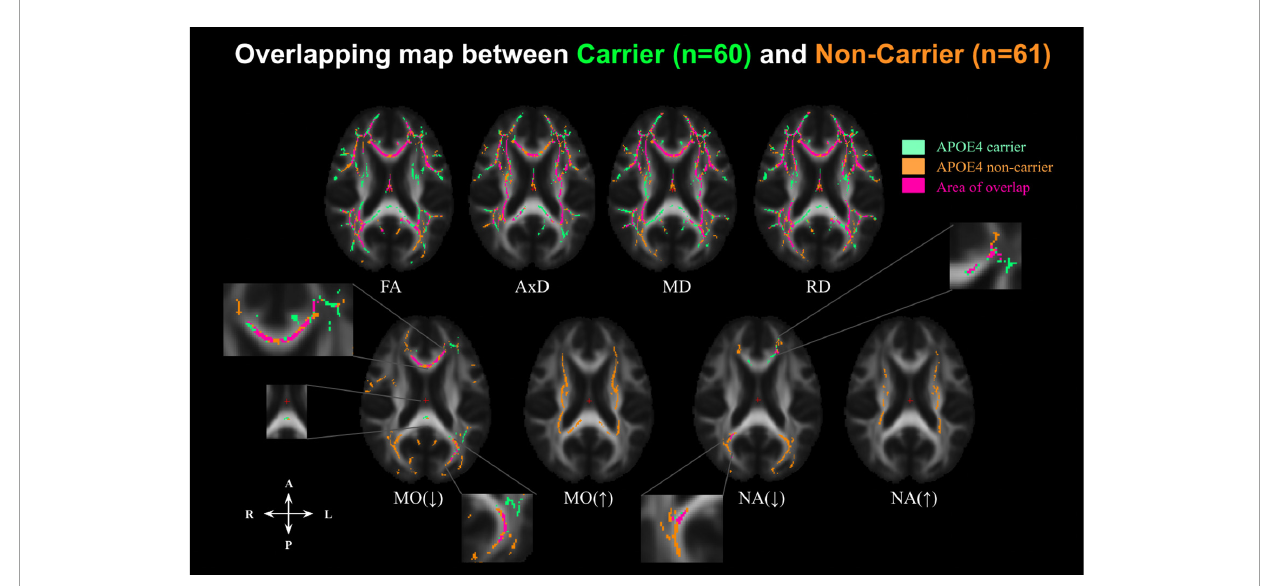
FIGURE3 Significant associations between DTI metrics and age across the whole-brain WM in cognitively normal APOE carriers (APOE4+, indicated in green) and APOE4 non-carriers (APOE4–, indicated in orange), along with overlaps between the groups (indicated in pink) at p < 0.05. Aging is associated with decreasing FA and increasing diffusivity (AxD, RD, and MD). However, MO and NA have bidirectional associations with age. MO( ↓ ) indicates where MO is negatively associated with age; MO( ↑ ) where MO is positively associated with age; NA( ↓ ) where NA is negatively associated with age, and NA( ↑ ) where NA is positively associated with age. FA, fractional anisotropy; MD, mean diffusivity; AxD, axial diffusivity; RD, radial diffusivity; MO, mode of anisotropy; NA, norm of anisotropy.